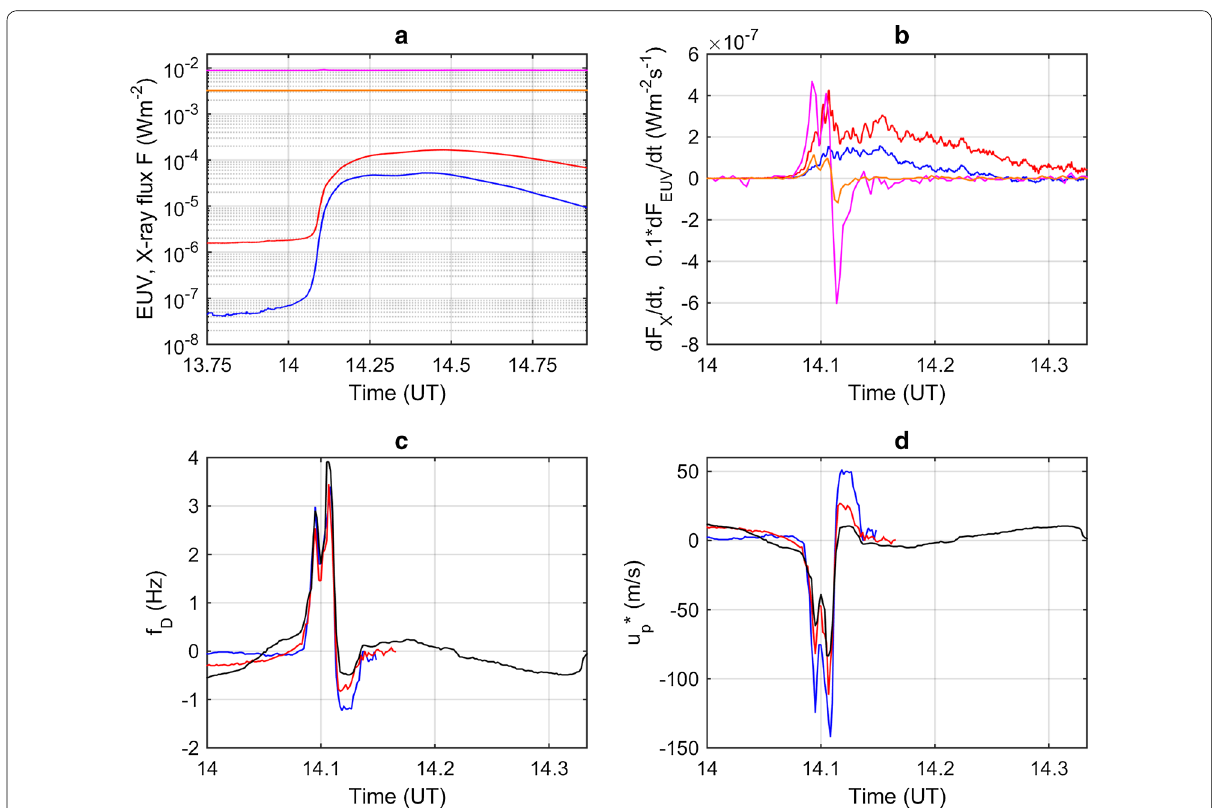
Fig. 4 a Ionizing fluxes recorded by GOES‑15 satellite on 22 October 2014 from 13:45 to 14:55 UT. X‑ray fluxes in the ranges 0.1–0.8 nm and 0.05–0.4 nm by red and blue, respectively. EUV H‑lyman‑alpha flux and EUV flux in the range 25–35 nm by magenta and orange, respectively. b Time derivatives of the X‑ray fluxes, dF X /dt, (red for 0.1–0.8 nm, blue for 0.05–0.4 nm) and 0.1 dF EUV /dt of the EUV H‑lyman‑alpha flux (magenta) × and of the 25–35 nm channel (orange). c Observed Doppler shift at f 7.04, 4.65 and 3.59 MHz by black, red, and blue, respectively. d Virtual plasma = velocity u P* obtained by Eq. (3) for f 7.04, 4.65 and 3.59 MHz by black, red, and blue, =